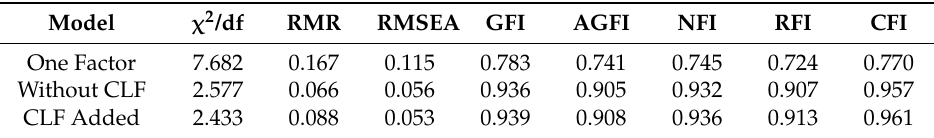
Table 2. Common method bias